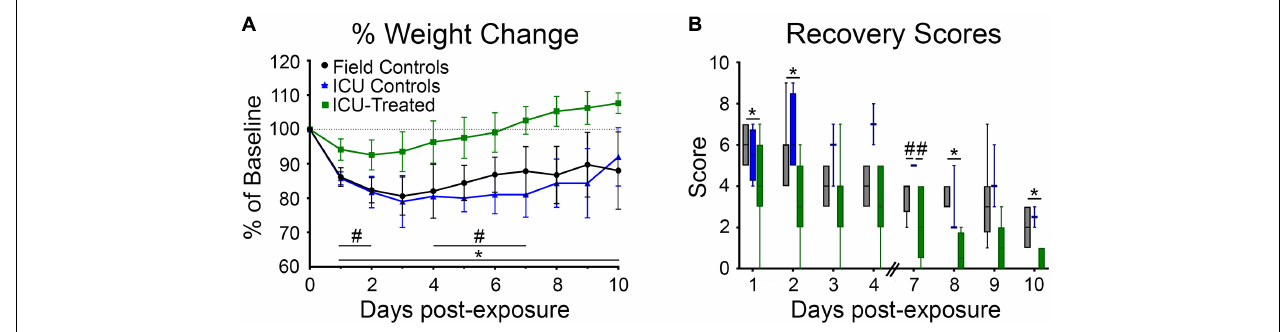
FIGURE 4 | Body weights and recovery scores for rats that were returned to their home cage following NA exposure. (A) Body weight was measured daily for 9 days following exposure and reported as percentage of pre-exposure weight. Field controls rats ( n = 8) never returned to 100% of their initial body weight, and a mixed-effects analysis with Tukey’s multiple comparison test showed that these rats had significantly lower normalized body weights than ICU-treated rats ( n = 16) on every day post exposure (* p < 0.05). ICU-treated rats also had significantly higher normalized body weights compared to ICU controls ( n = 4) on post-exposure days 1–2 and 4–7 (# p < 0.05). Data points show mean values for each treatment group, and error bars show standard deviation. (B) Rats were assessed daily (except on days 5 and 6) for signs of recovery as outlined in Supplementary Table 1 , with higher scores indicating poorer condition. A mixed-effects analysis with Tukey’s multiple comparison test showed that ICU-treated rats ( n = 16) displayed significantly lower recovery scores compared to field controls rats ( n = 8) on post exposure days 1, 2, 8, and 10. ICU controls had significantly higher recovery scores than both other treatment groups on day 7 post-exposure. Lines show median values for each treatment group, boxes show 25th–75th percentiles, and whiskers show 5th–95th